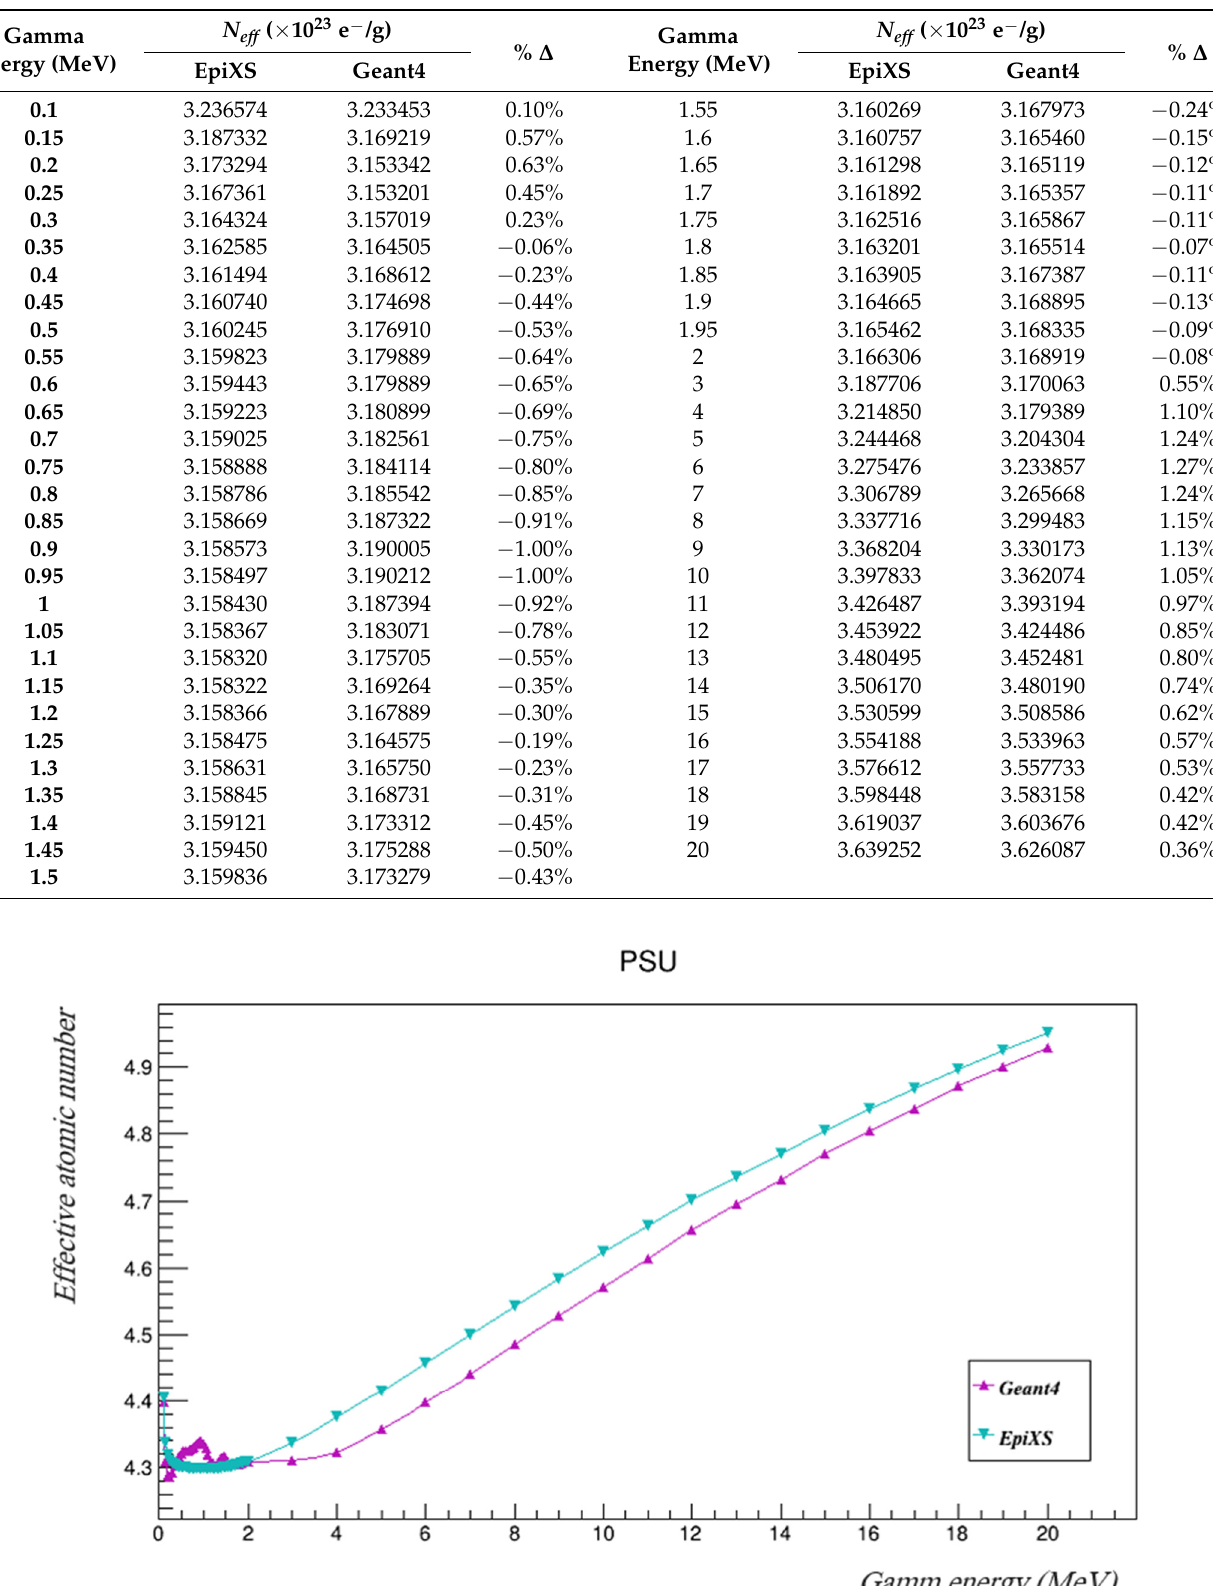
Table 5. The electron effective densities of PSU in the investigated energy range.